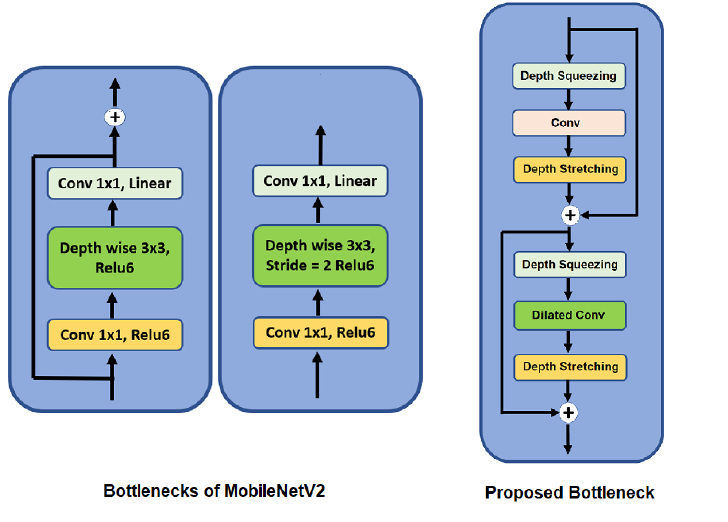
Figure 3. Comparison between the proposed bottleneck and the bottleneck of MobileNetV2. For convolution with stride 2, the bottleneck of MobileNetV2 does not have the residual connection. The details of the proposed bottleneck are given in Section